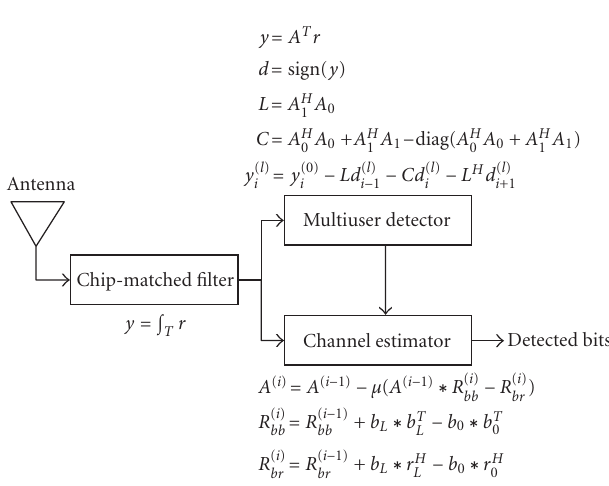
Figure 4: An iterative multiuser receiver, represented as a block di- agram in which each block contains an algorithm specified by a set of